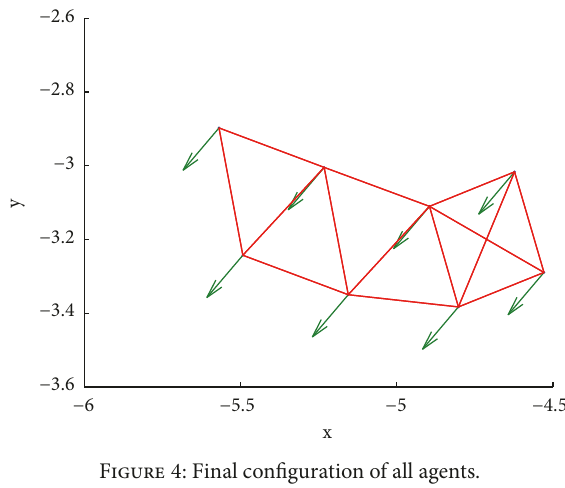
Figure 4: Final configuration of all agents.